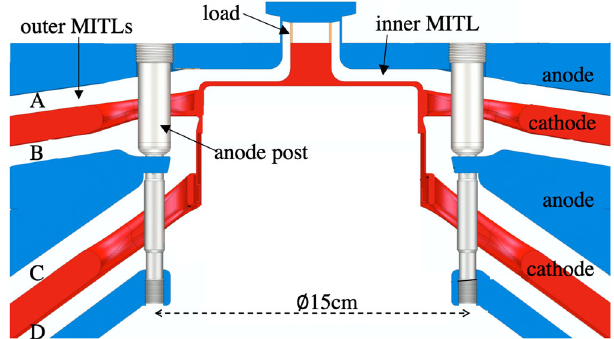
FIG. 2. A cross section of the Z machine outer MITLs, ∅ 15 cm double post-hole convolute (current adder), and inner MITL [19].